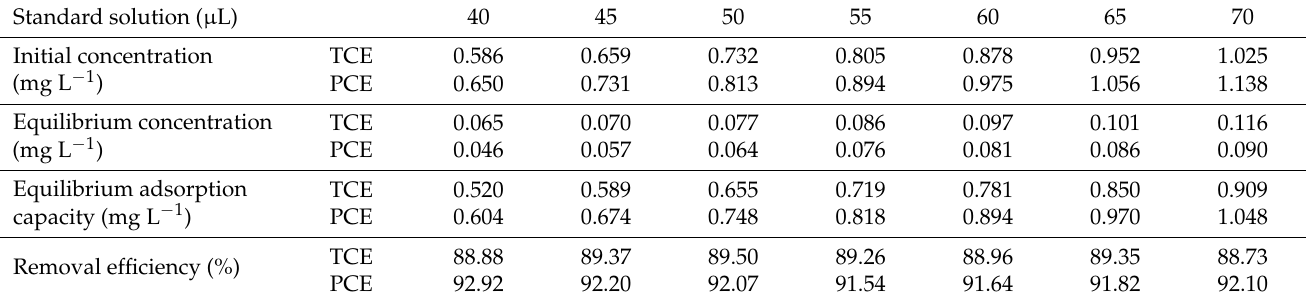
Table 8. Experimental data of activated carbon for different initial concentrations of TCE and